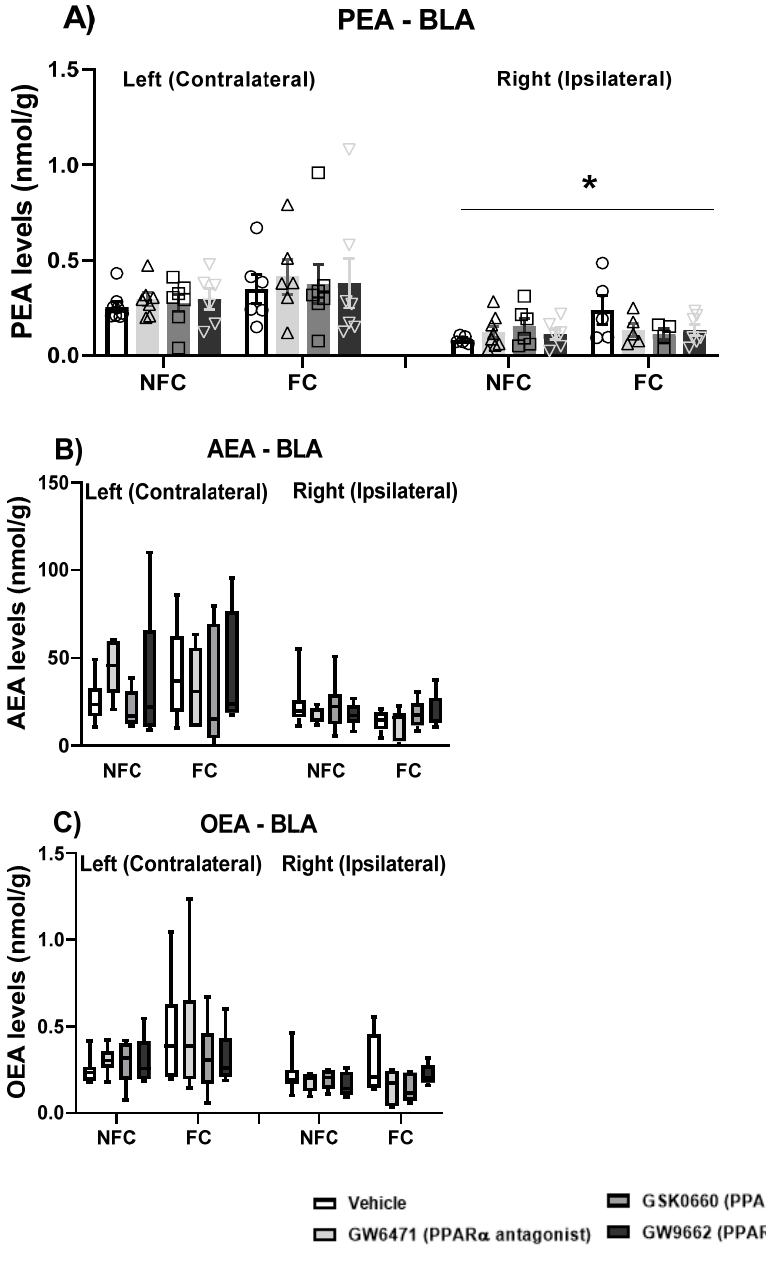
Figure 7. Effects of fear-conditioning and intra-BLA administration of selective PPAR α , PPAR β / δ , and PPAR γ antagonists on the levels of PEA ( A ), AEA ( B ), and OEA ( C ). Two-way ANOVA revealed a significant effect of side on PEA levels (* p < 0.05). Data are expressed as mean ± S.E.M ( A ) or median with interquartile range and min/max ( B , C ), each symbol represents one individual, ( n = 7–9 rats per group).